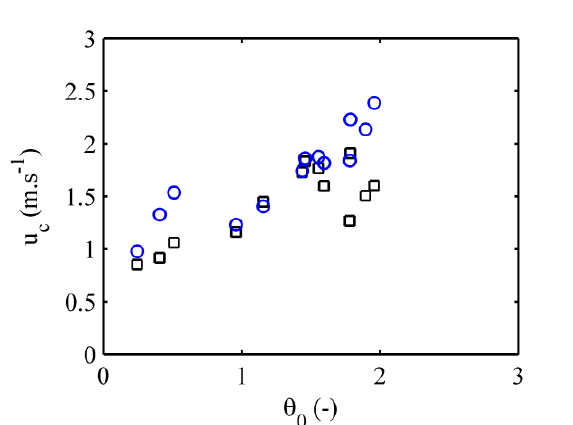
Fig. 12. Local velocity at top of transport layer versus dimensionless bed shear stress for FA60 flow. Legend: black square – experiment, blue circle – model prediction.